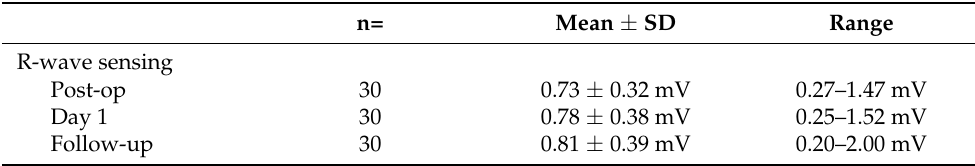
Table 2. R-wave sensing